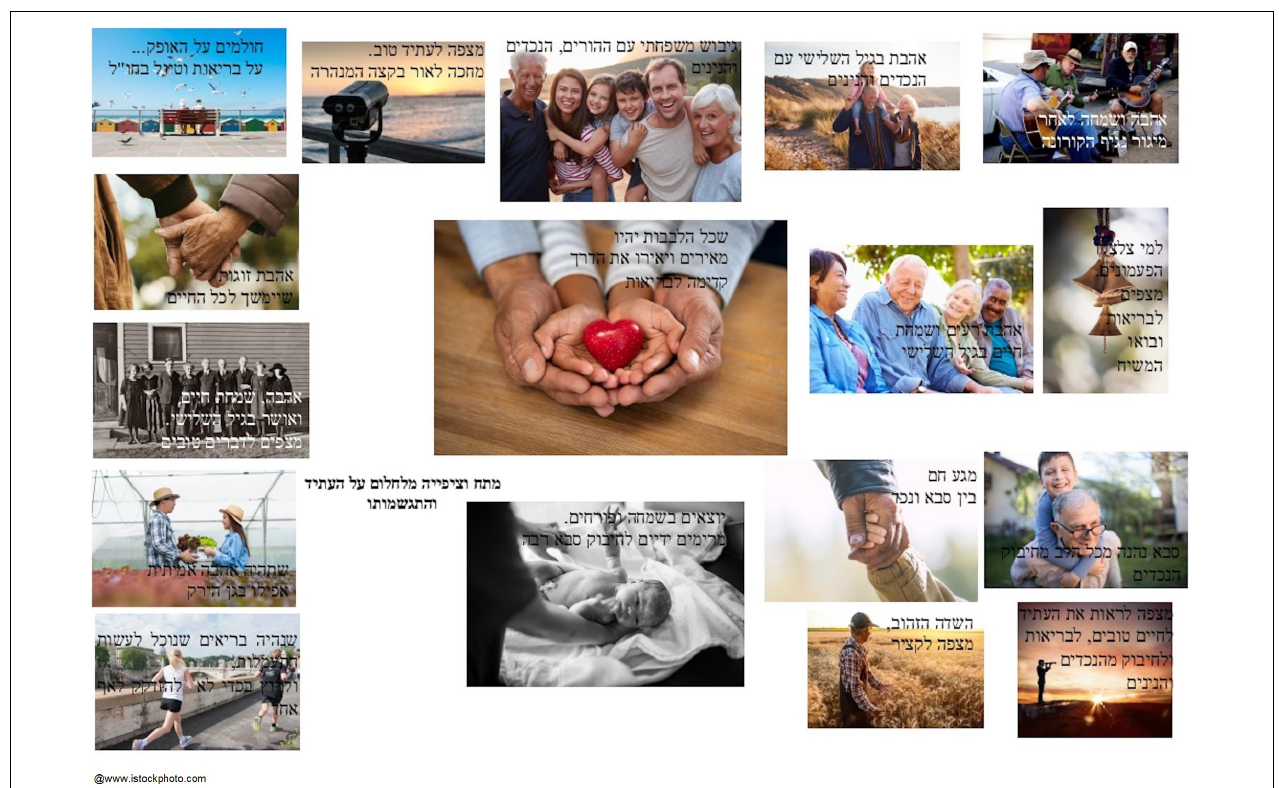
FIGURE 7 | A photocollage by Itzhak: “Tenseness and anticipation while dreaming about the future and its